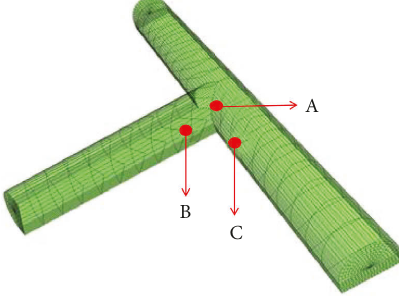
Figure 9: Layout of measuring